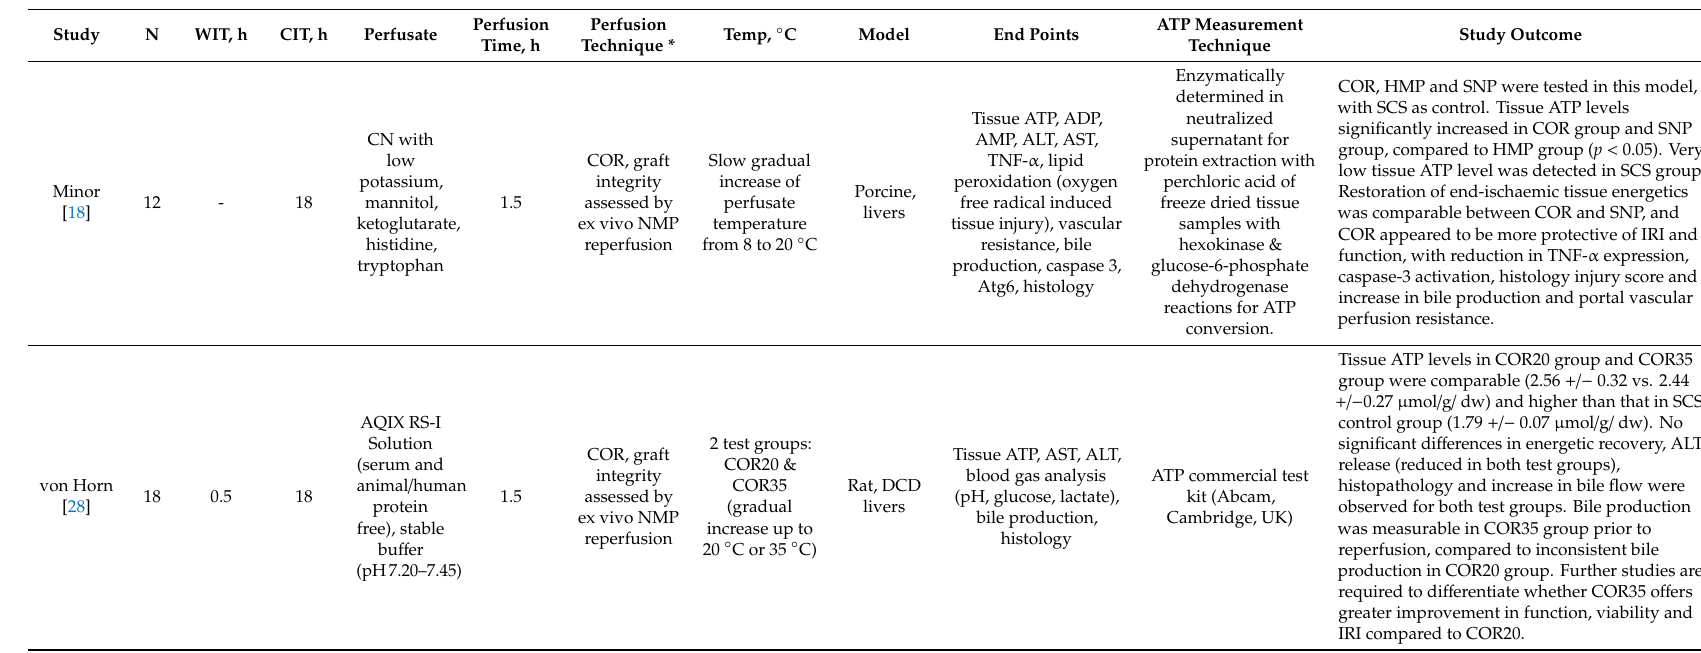
Table 3. Characteristics and outcomes of key pre-clinical and animal studies investigating COR preservation of